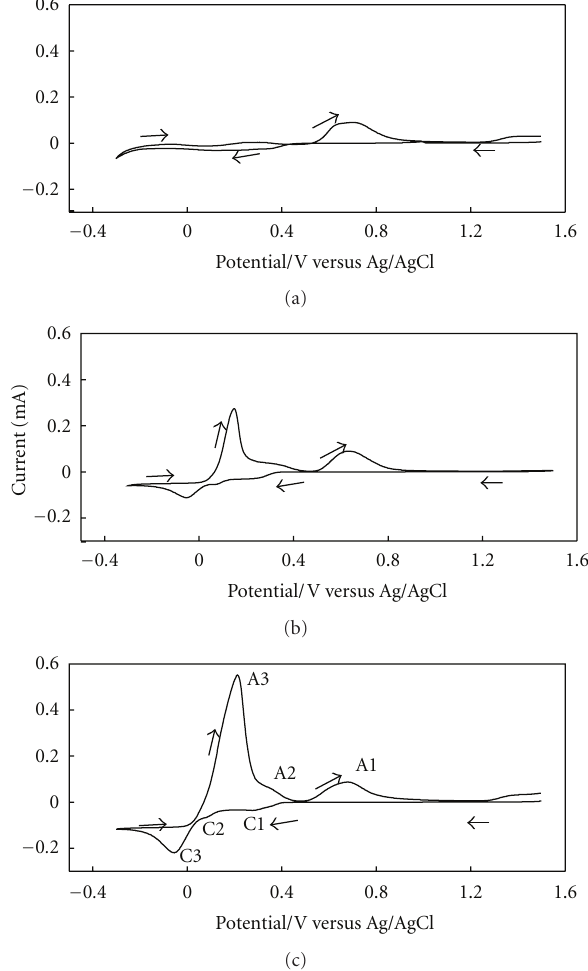
Figure 3: Cyclic voltammograms of BBD electrode in solutions with (a) (1: 1), (b) (5:1), and (c) (10:1) Cu(II):Pd(II) ratio. Scan rate of 10 mV s − 1